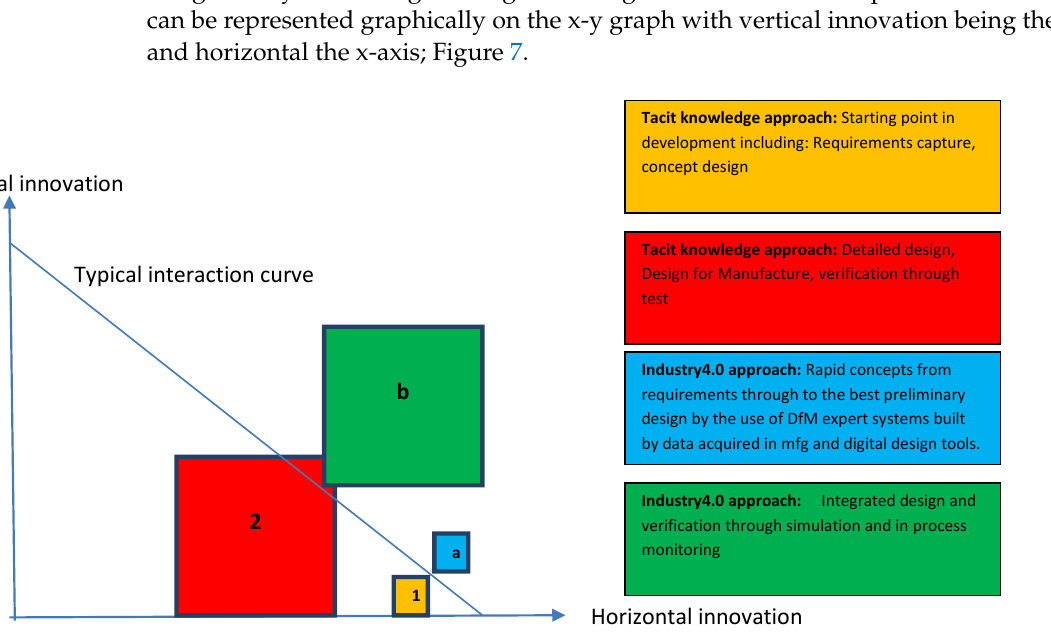
Figure 7. Innovative perspective for Composite Manufacturing.